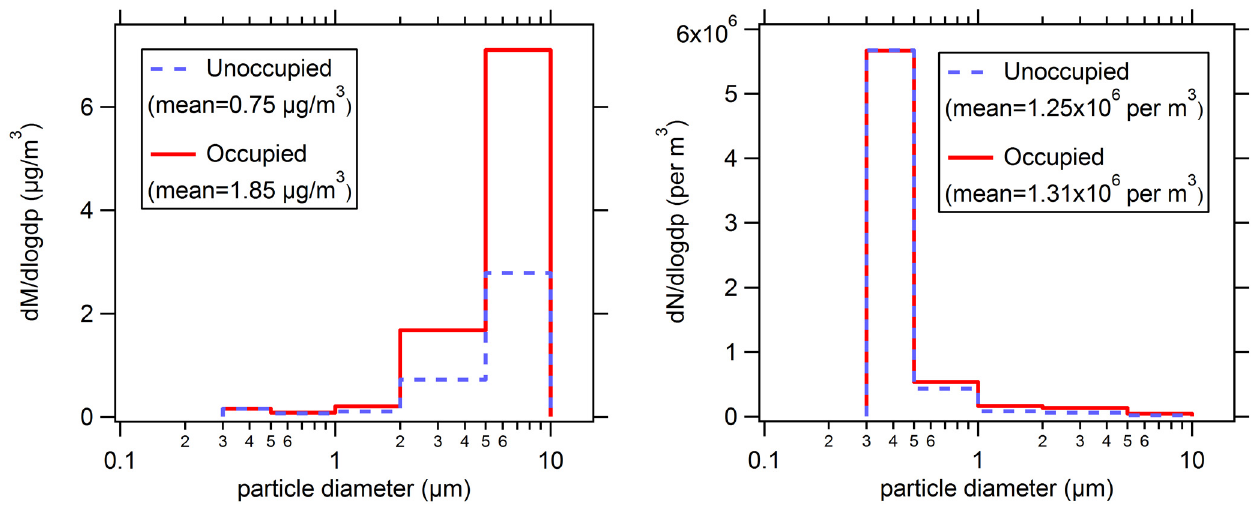
Fig 5. Size distributions of total particle number (left) and mass (right) concentrations averaged across all baby rooms separately considering occupied and unoccupied periods. The data from the largest size channel of the optical particle counter was omitted and an upper limit of 10 μ m diameter was adopted.